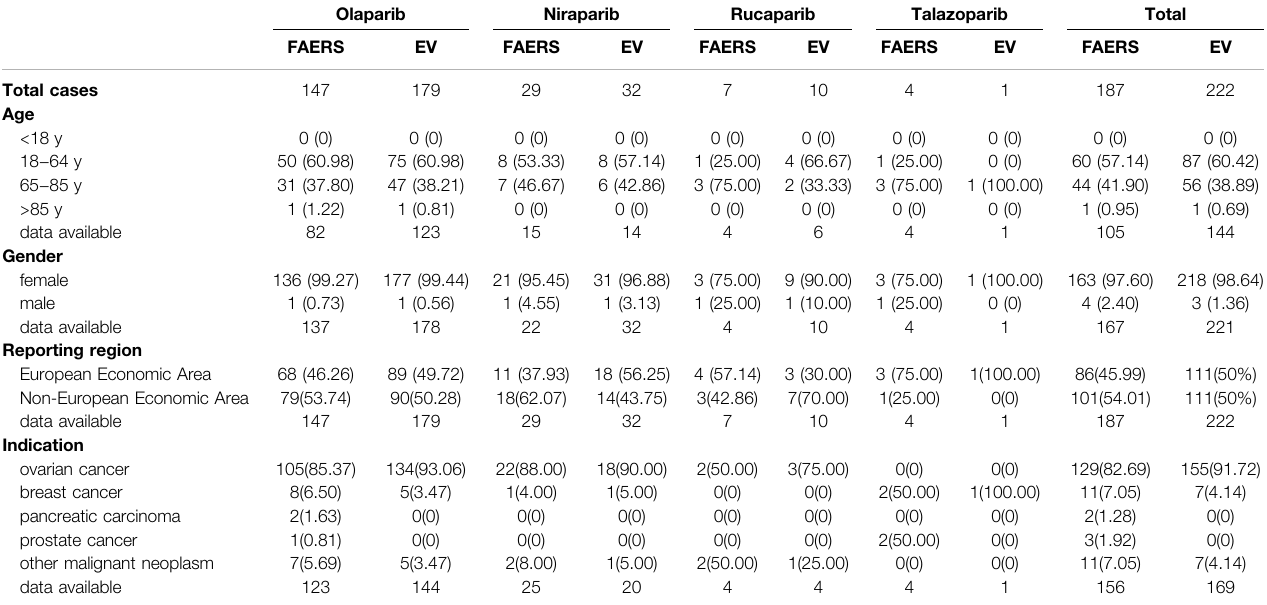
TABLE 1 | The characteristics of MDS reported by PARP inhibitors in FAERS and EV database. Olaparib Niraparib